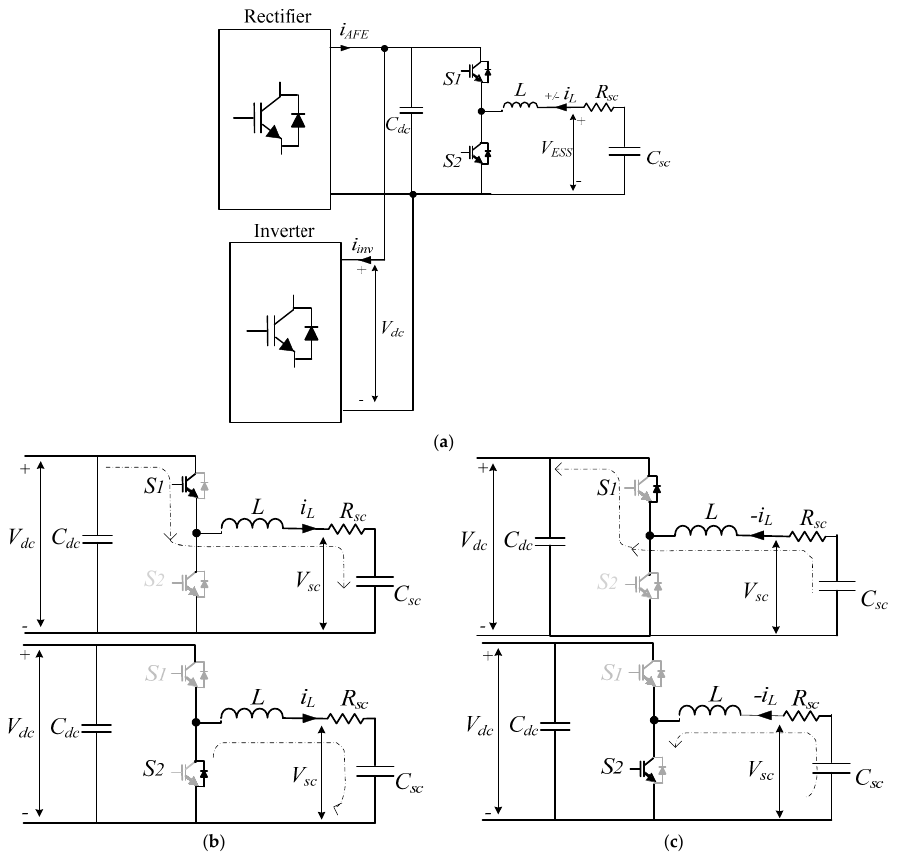
Figure 4. Half bridge (HB) dc-dc bidirectional converter of supercapacitor energy storage (SCES); ( a ) dc-link with electrical power converters; ( b ) buck mode operation of the bidirectional dc-dc converter; and ( c ) boost mode operation of the bidirectional dc-dc